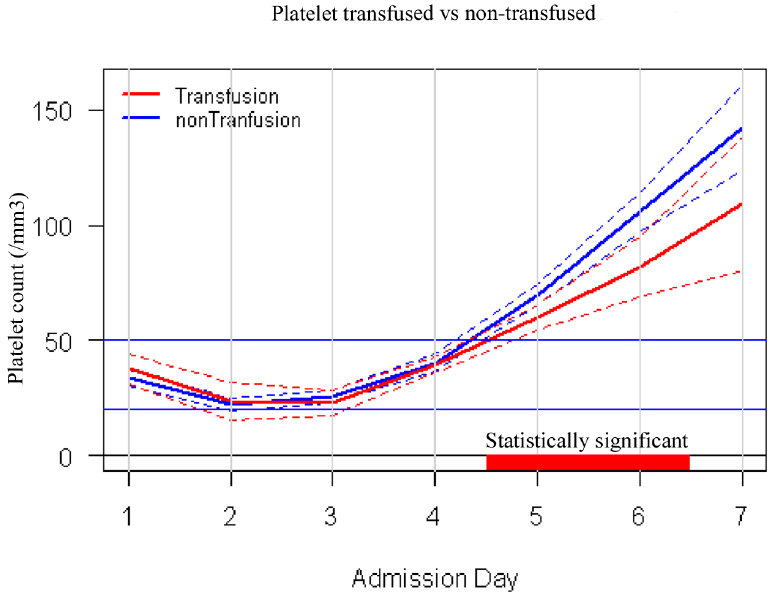
Fig 1. Platelet trend between treatment groups. Patients receiving platelet transfusion took significantly longer time to recover to platelet count of more than 50,000/mm 3